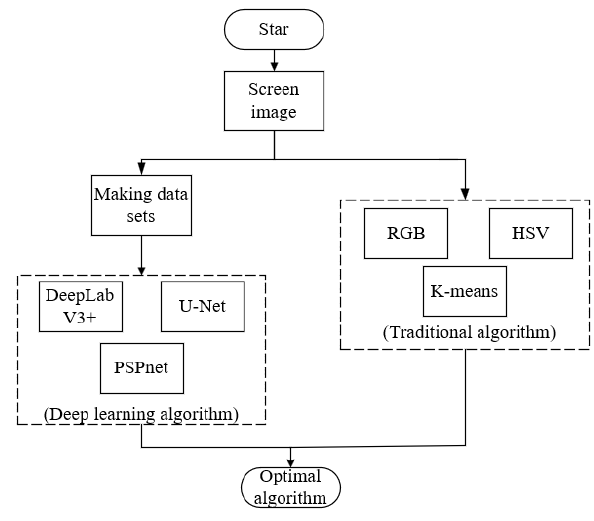
Figure 9. Flow chart of Sichuan pepper image segmentation methodology.